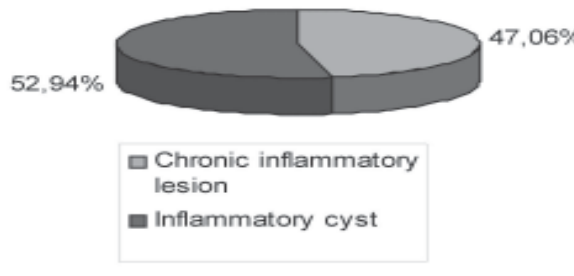
FIGURE 5- Percentage of chronic apical periodontitis and inflammatory cyst that were diagnosed only by the histological examination and not by clinical